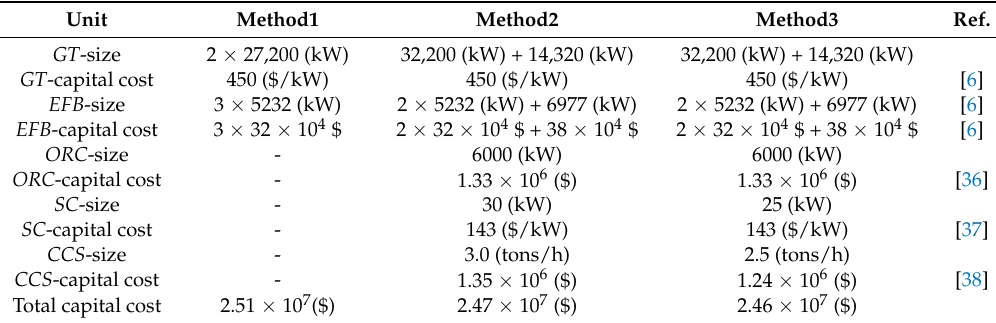
Table 4. Equipment components of energy system and the capital cost.